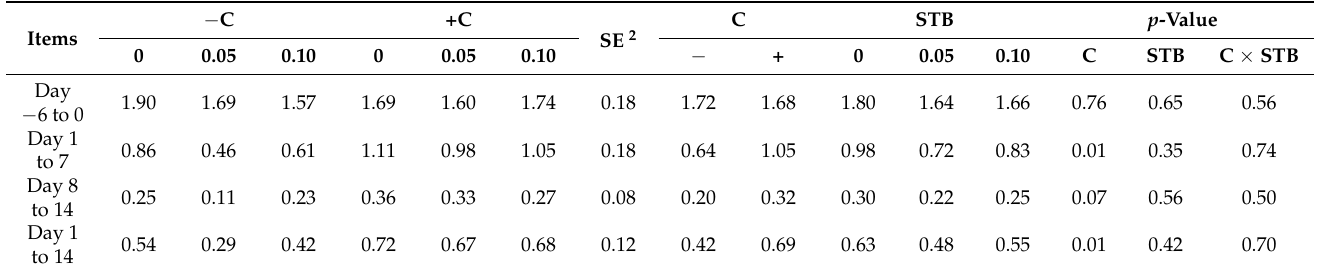
Table 3. Effects of stimbiotic on the fecal score 1 of pigs challenged with STEC.